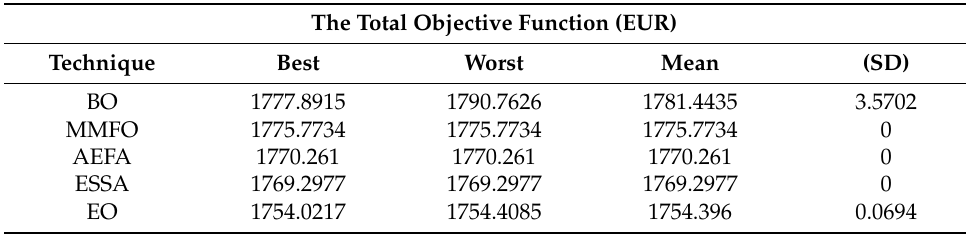
Table 9. Comparison of the statistical results of the objective function in Scenario 3.